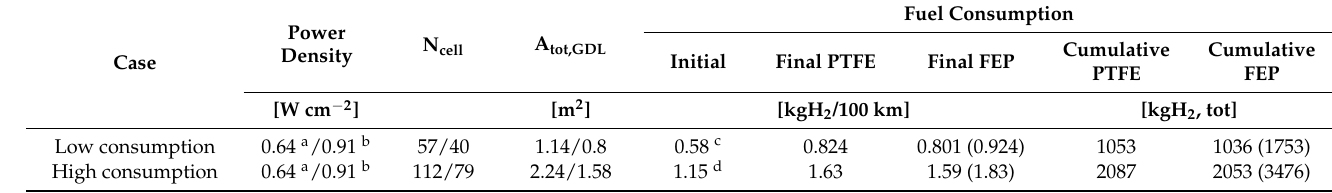
Table 2. Fuel-cell parameters and fuel consumption (initial, final, and cumulative) for the two fuel cells (PTFE- and FEP-based) in the low- and high-consumption cases. The values for FEP refer to the consumption after 4109 h (150,000 km), and in parenthesis, to the consumption after 6387 h (233,180